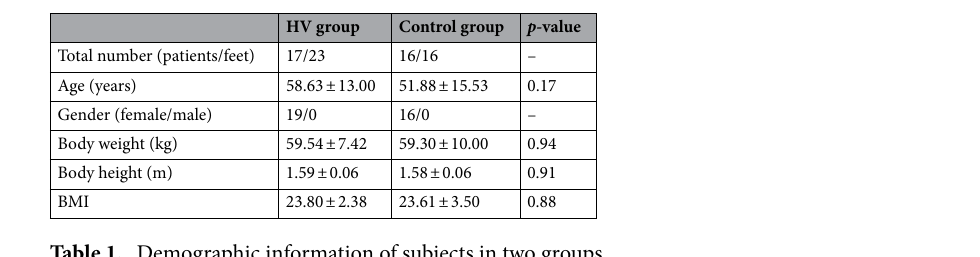
Table 1. Demographic information of subjects in two groups.